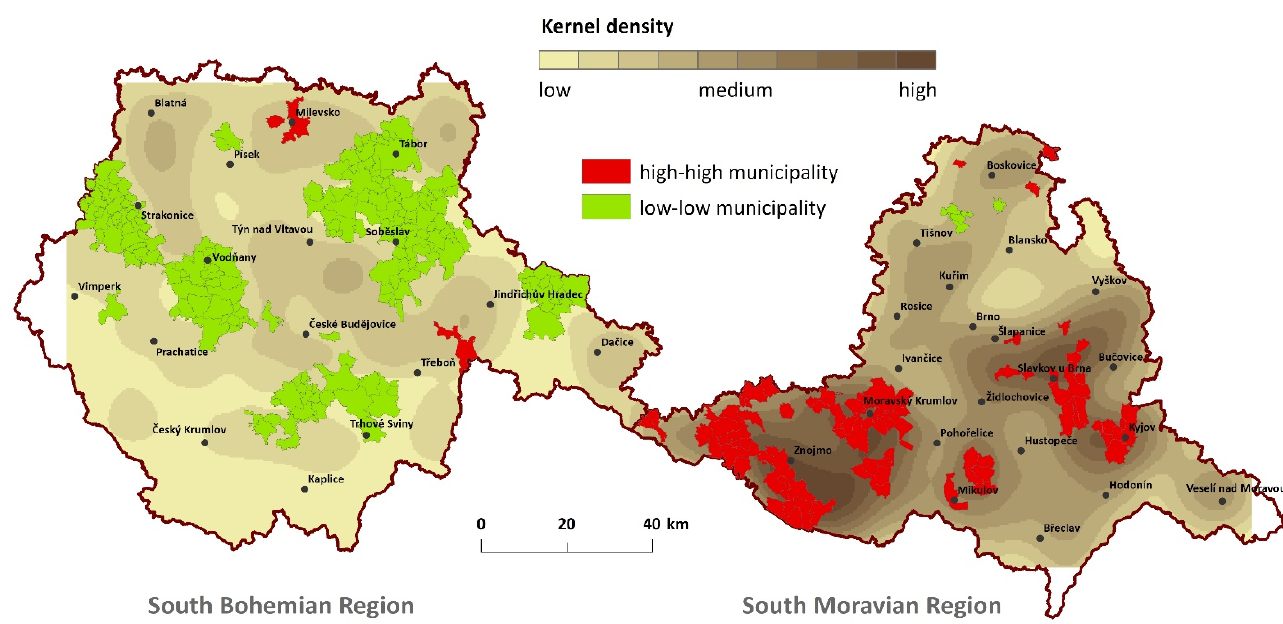
Figure 4. Location of the clusters of regions with a high-high (red) and a low-low (green) occurrence of post-agricultural brownfields after the year 2004 (based on the application of the Anselin Local Moran’s I method) on iso-lines calculated by the Kernel density estimation. A geographical description of the area can be found in Figure 1.